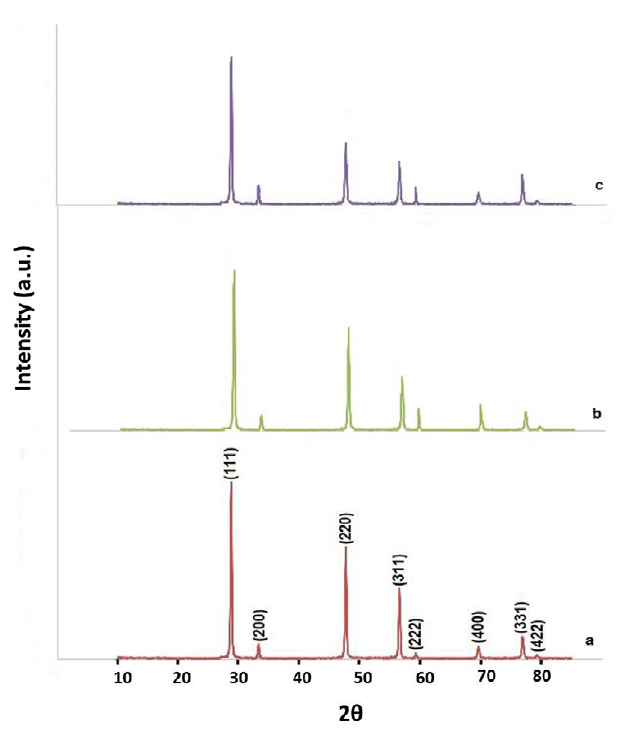
Fig. 1. X-ray powder diffraction pattern of Yb x Zn 1− x S ((a) x = 0 . 0, (b) x = 0 . 04, (c) x = 0 . 06) synthesized at 160 °C and 12 h